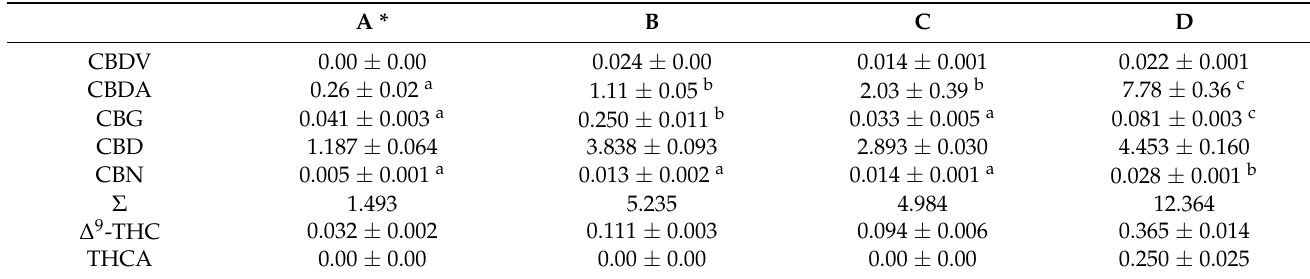
Table 3. CBD and THCA contents in hemp concentrates